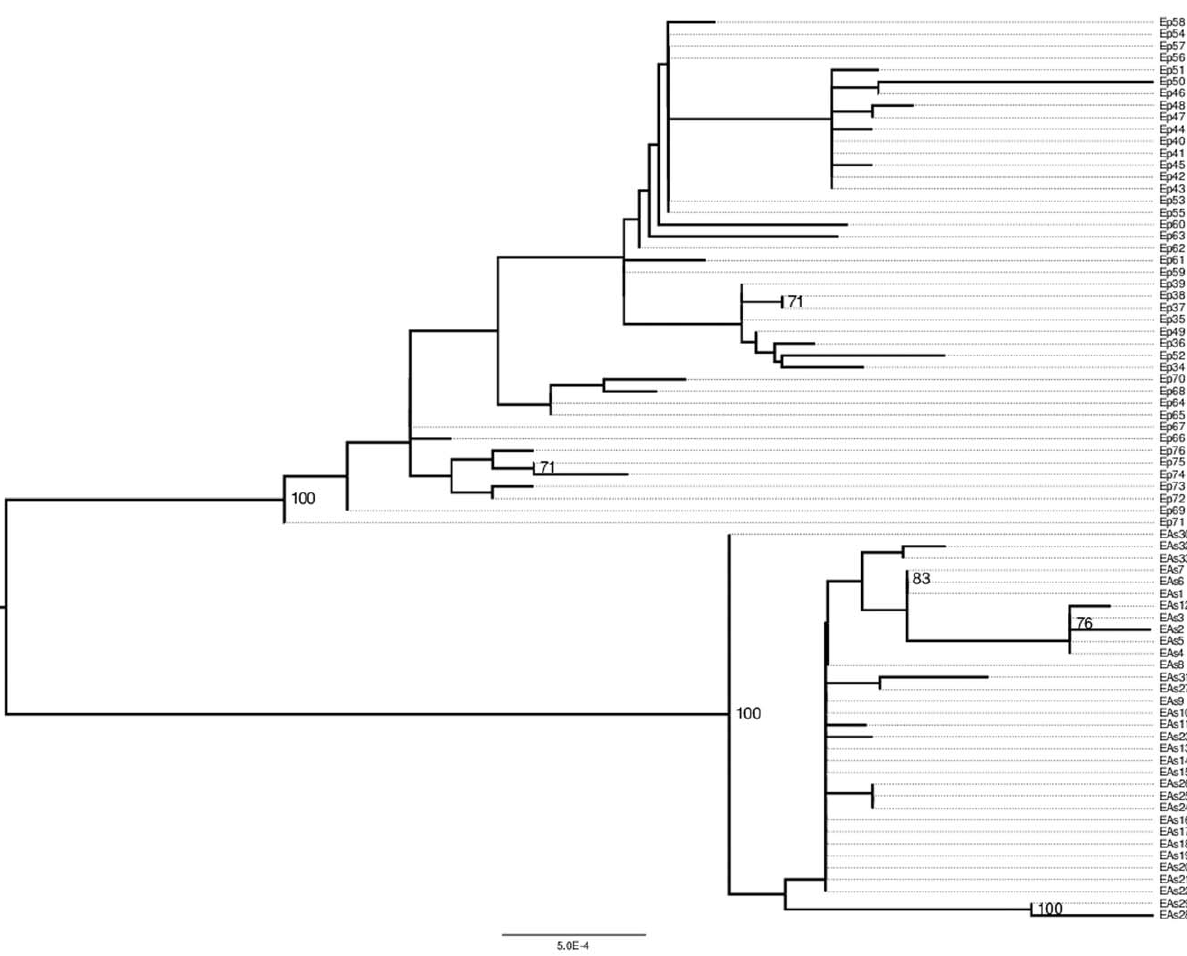
Figure 1. Maximum Likelihood phylogenetic tree for 76 HPV16 samples from Anyang. This tree is constructed using whole genome sequences and bootstrap scores larger than 70% are displayed. The tree itself is shown in bold, the sample IDs are linked through dashed lines. EPs are the European Prototypes and EAs are the European Asian types.